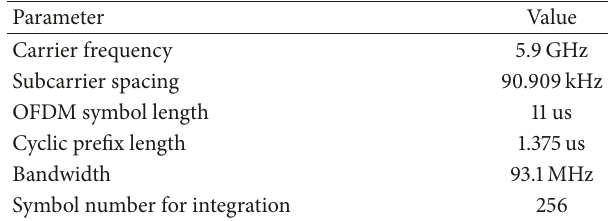
Table 1: OFDM RadCom system